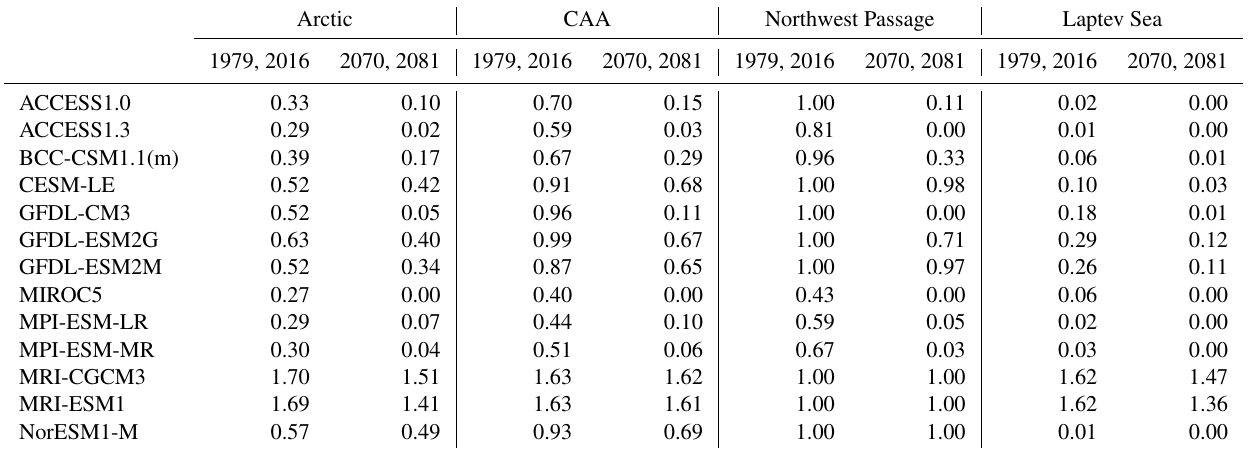
Table 1. Fraction of NIC landfast ice extent (magenta line in Fig. 2b) covered by slow, packed ice with a duration of more than 5 months for different models, regions and